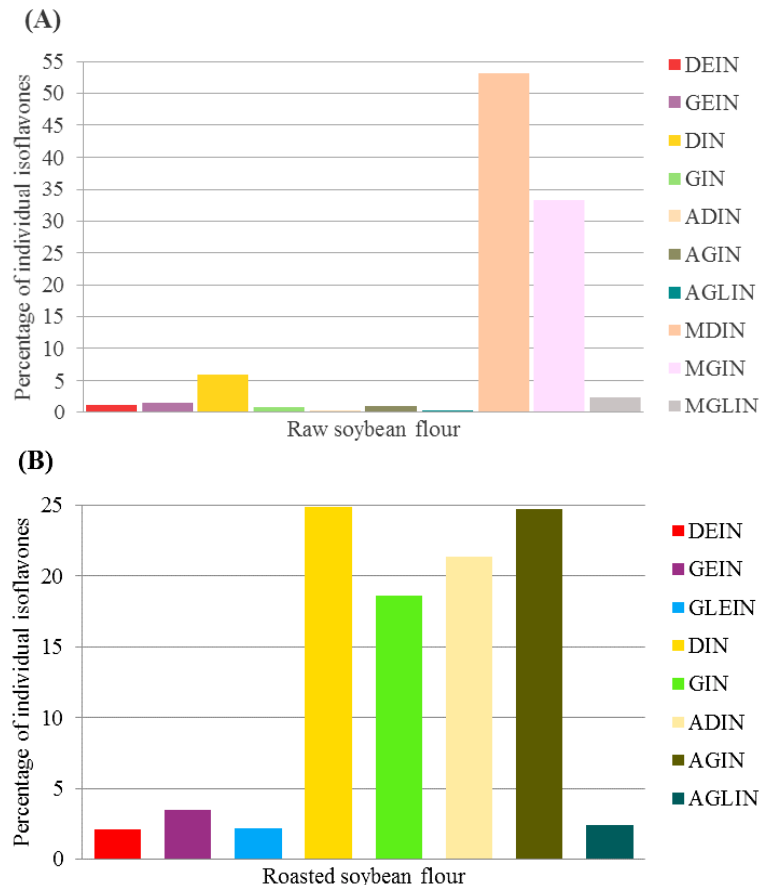
Figure 4. Composition of isoflavones in ( A ) RWSF and ( B ) RSF. The percentage of individual